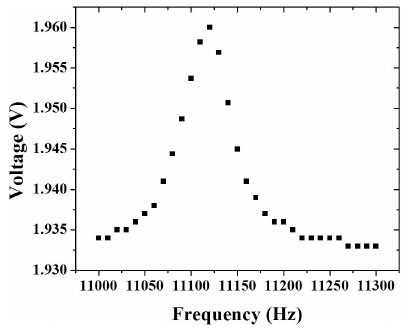
Figure 6. Frequency response of TFG sensing mode.